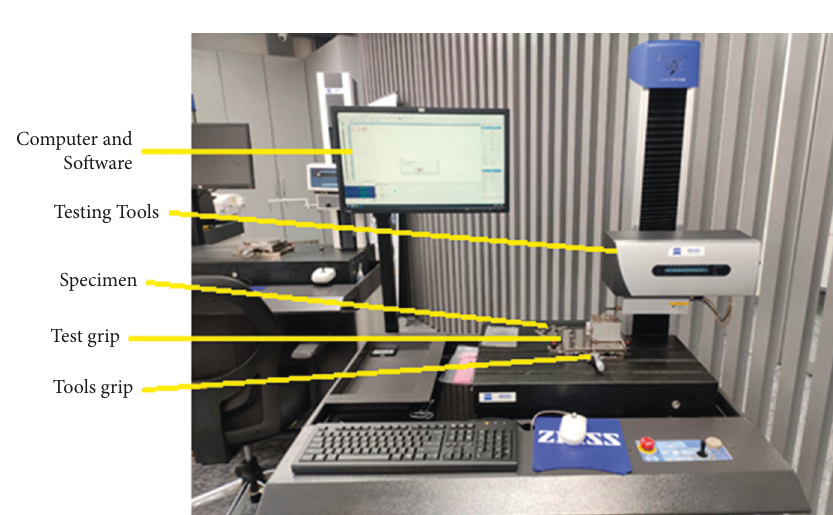
Figure 2: Surfcom INEX linear coordinate measuring machine.